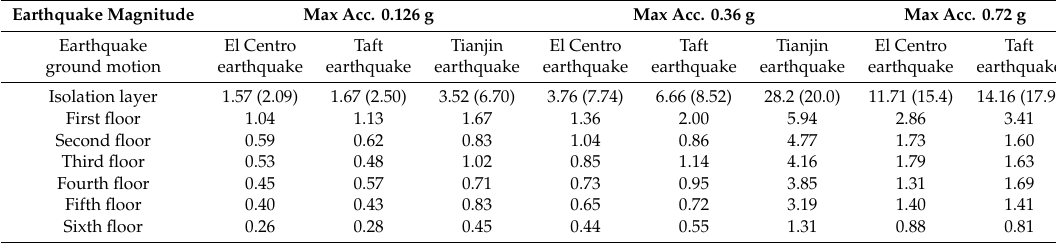
Table 1. The peak interlayer drift under di ff erent seismic inputs in continuous control (mm). Earthquake Magnitude Earthquake ground motion Isolation layer